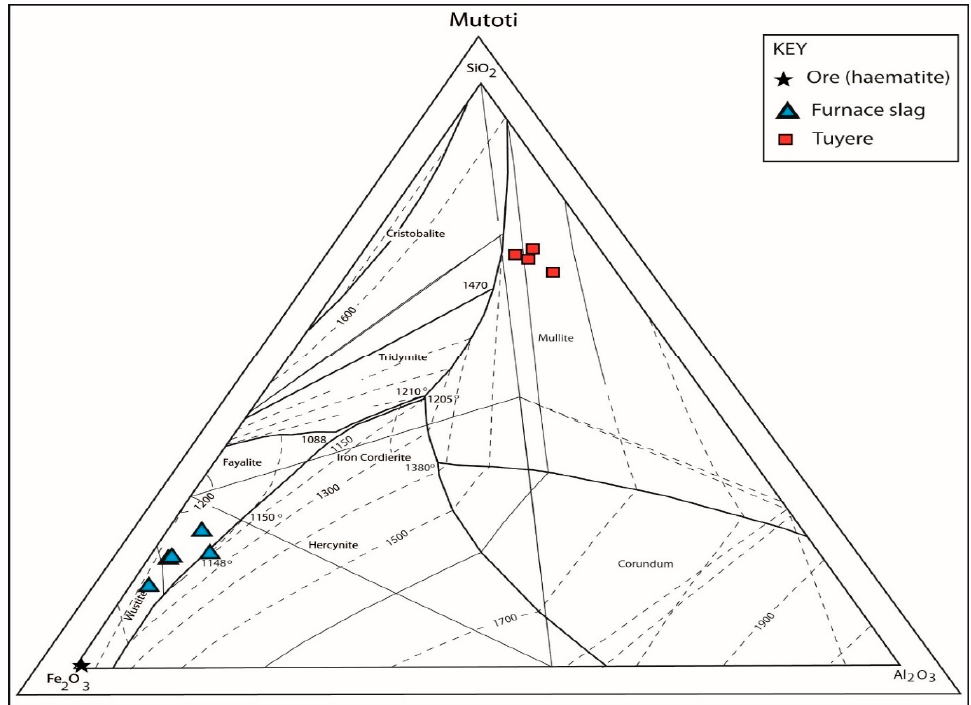
Figure 4. Ternary plot diagram for Mutoti 2 site.